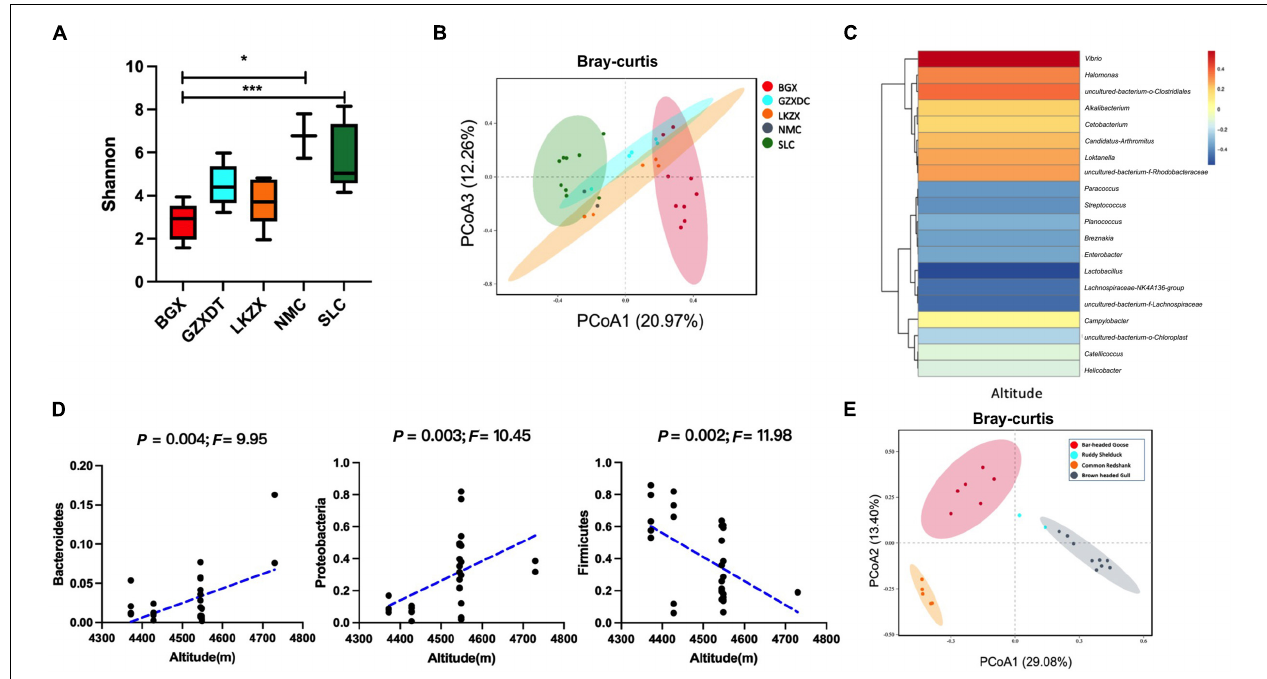
FIGURE 2 | Gut microbial diversity of brown-headed gulls from five habitats and gut microbial diversity of four species of birds in BGX. (A) The Shannon index. (B) PCoA plots of Bray–Curtis distance. (C) Correlation between three phyla and altitude (Spearman). (D) Heat map of correlation between microbial composition and altitude at the genus level. (E) PCoA plots of Bray–Curtis distance of four species in BGX. Data indicate mean ± SEM values. * P < 0.05 and *** P <